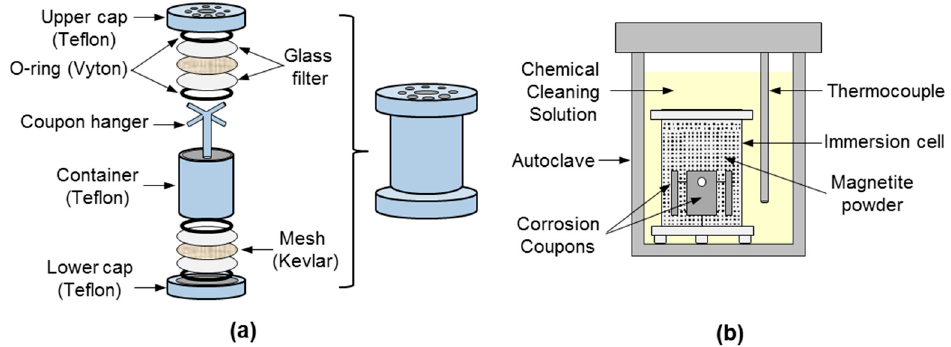
Figure 2. Schematics of the apparatus used for the immersion corrosion tests: ( a ) immersion cell, and ( b ) arrangement in the autoclave.